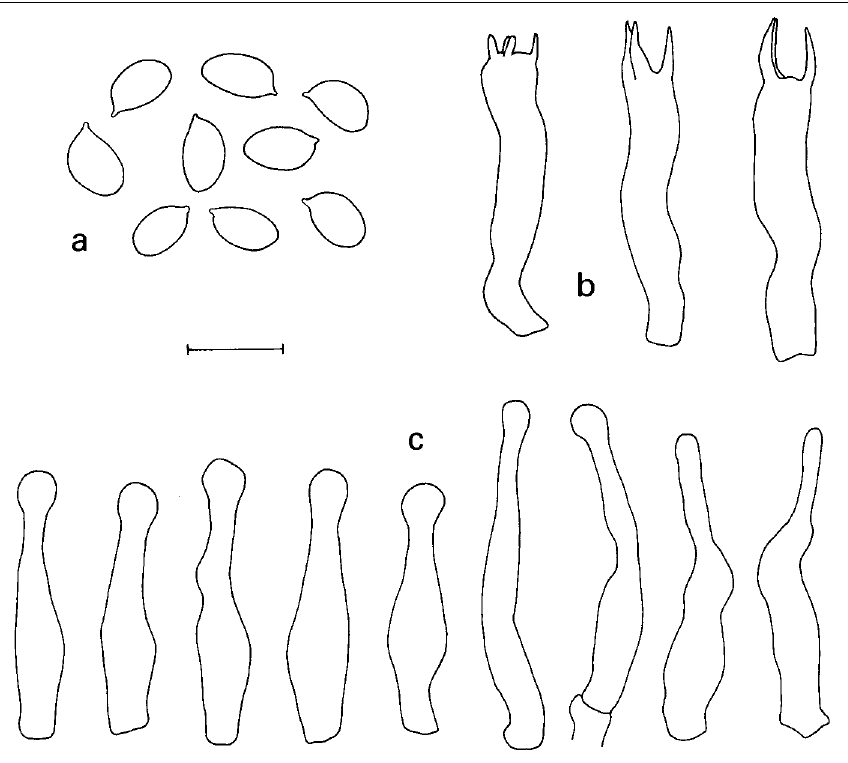
Fig. 1. Hebelomina neerlandica : a spores, b basidia, c cheilocystidia (specimen A. Fraiture 2927 , BR); scale bar = 10